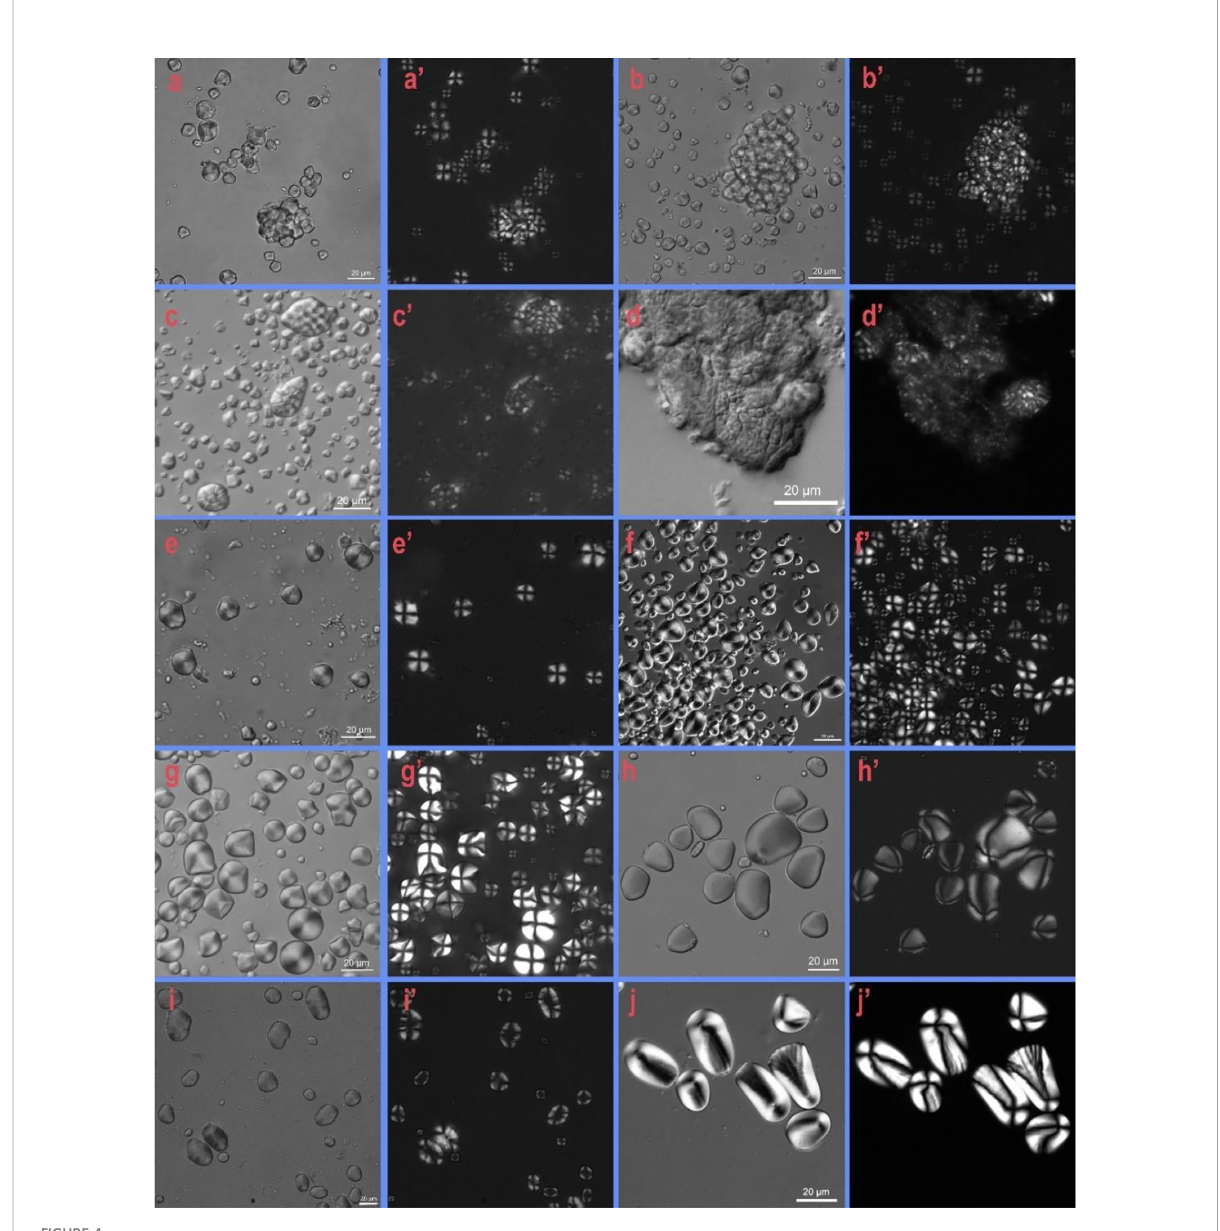
FIGURE 4 Examples of starch grain morphology from the modern reference (scale bar: 20 m m): ( AA ’ ) foxtail millet ( Setaria italica ); (BB ’ ) broomcorn millet ( Panicum miliaceum ); (C, D ’ ) rice ( Oryza sativa ); (EE ’ ) job ’ s tears ( Coix lacryma-jobi ); (FF ’ ) acorn ( Quercus acutissima ); (GG ’ ) snake gourd ( Trichosanthes kirilowii) ; (HH ’ ) Chinese yam ( Dioscorea polystachya ); (II ’ ) bean ( Vigna adenantha ); (JJ ’ ) lotus root ( Nelumbo nucifera